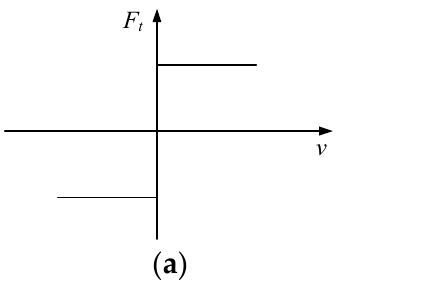
Figure 10. Coulomb friction model and model with modified coefficient introduced: ( a ) Coulomb friction model; ( b ) Coulomb friction model with modified coefficient introduced.